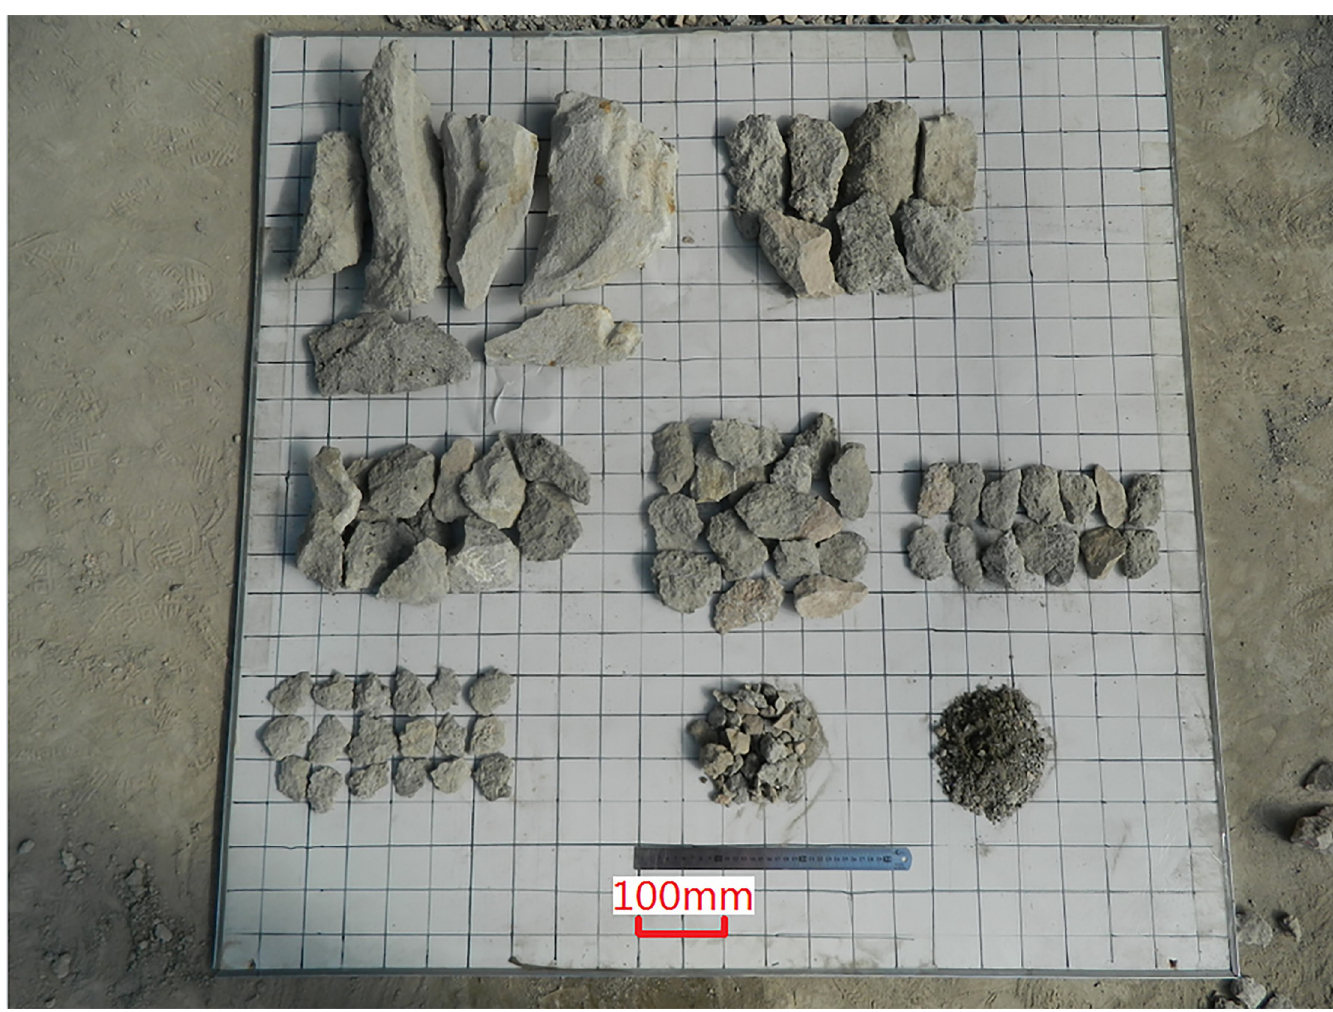
Fig 28. Typical geometry of